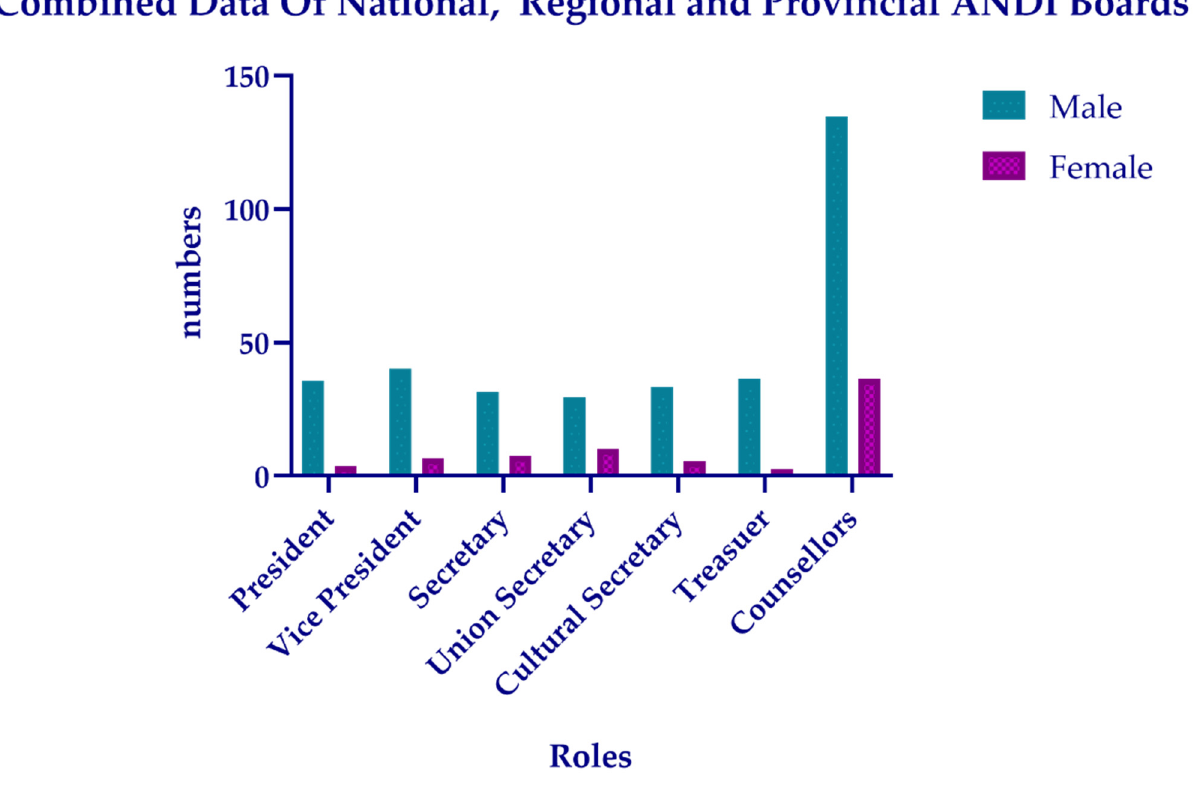
Figure 3. Graphical representation of the roles and gender distribution in national, regional, and provincial ANDI boards.